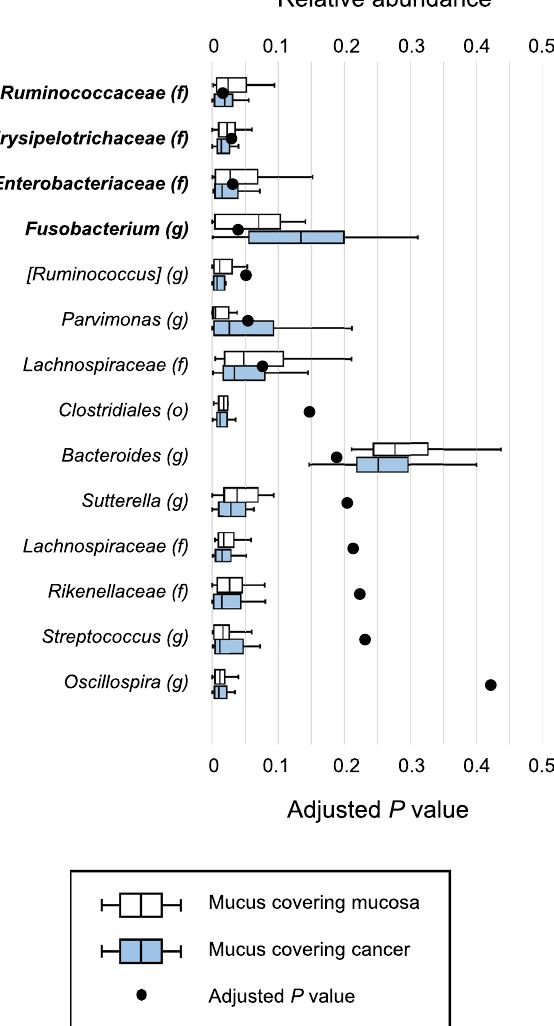
Figure 4. Comparisons of relative abundance in the mucus covering the mucosa and the mucus covering cancer tissue at up to the genus level by boxplot. Whiskers are extended to the most extreme data point, which is no greater than 1.5 × the interquartile range from the edge of the box in the boxplot. Statistical significance was determined using the Wilcoxon signed-rank test. The Benjamini–Hochberg method for controlling the false- discovery rate was used for multiple